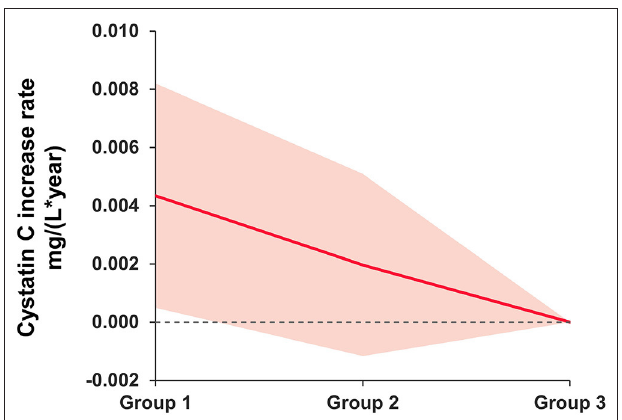
FIGURE 2 | Mean difference rate of change in serum cystatin C (mg/L) between baseline depressive symptom groups. Group 1 as persistent depressive symptoms. Group 2 as episodic depressive symptoms. Group 3 as no depressive symptoms. The group 3 was the reference group. Solid lines represent mean differences in serum cystatin C (mg/L) after adjusting for age, sex, race, body mass index, hypertension, and diabetes. The shadows represent the 95% CIs. The detailed results are presented in Table 3